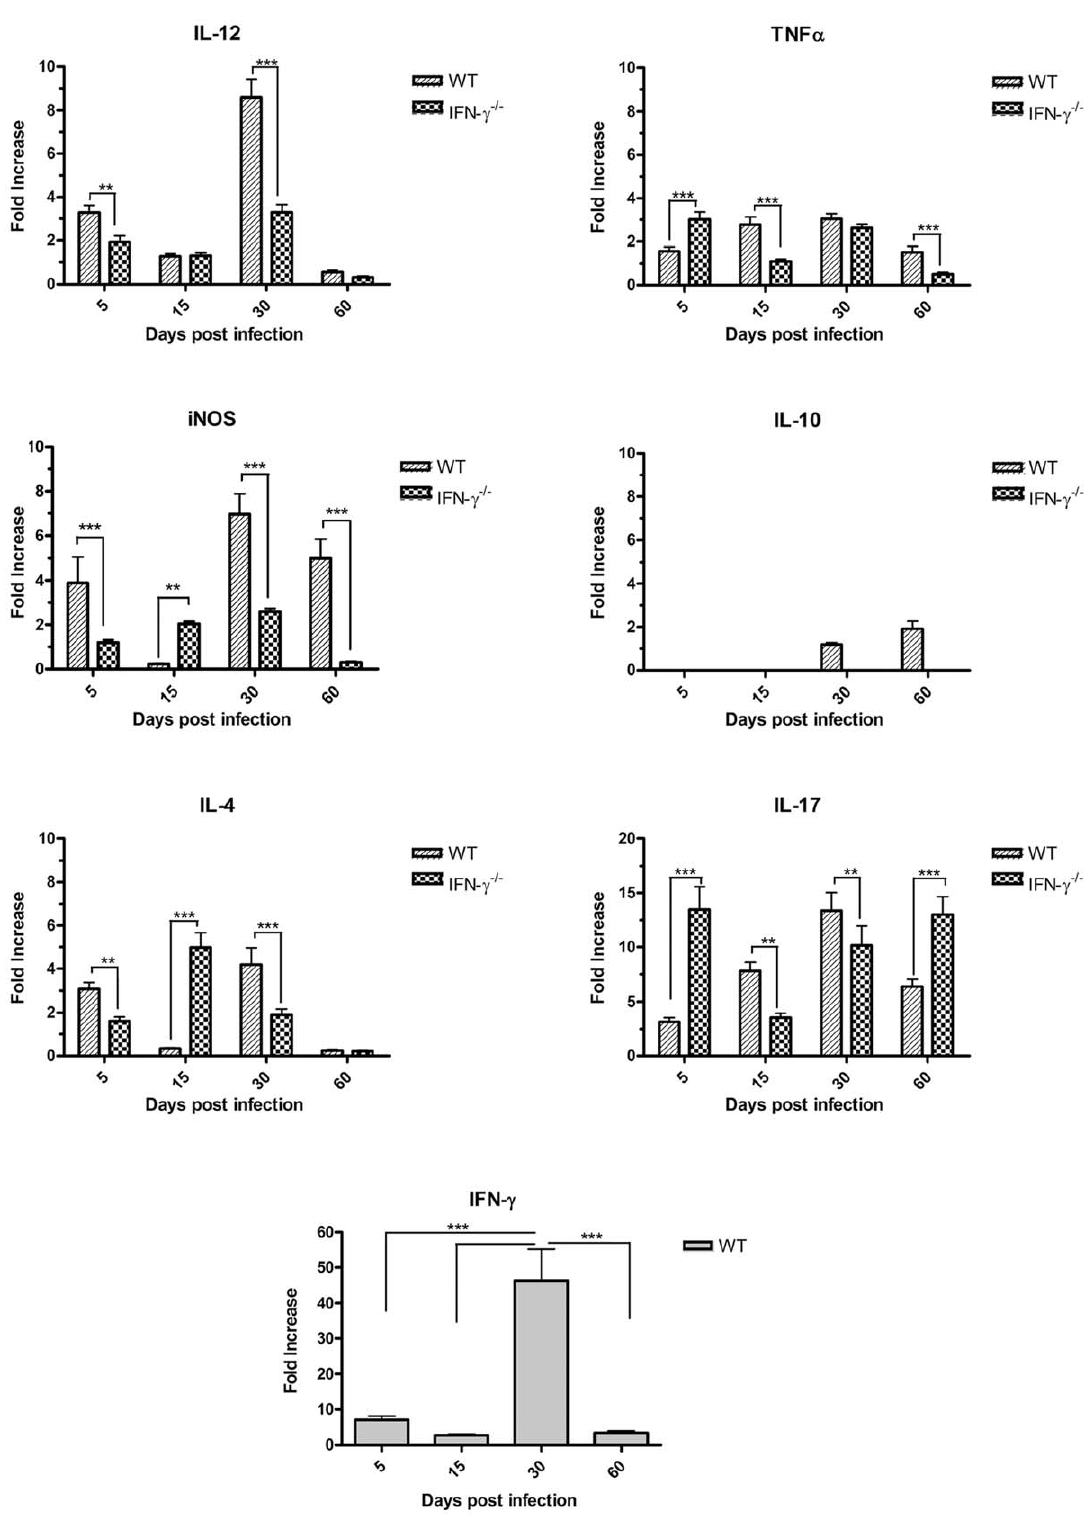
Figure 6. Expression of cytokine genes in lung cells of mice infected with H27 strain. Experiments were performed and results of cytokine gene expression determination were presented exactly as described in the legend to Fig. 5.